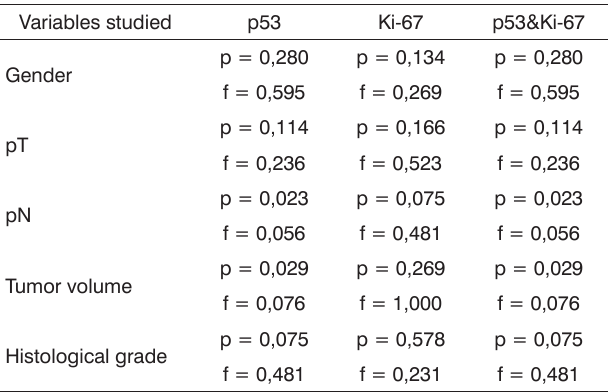
Table 1. Statistical correlation of the variables studied with p53,